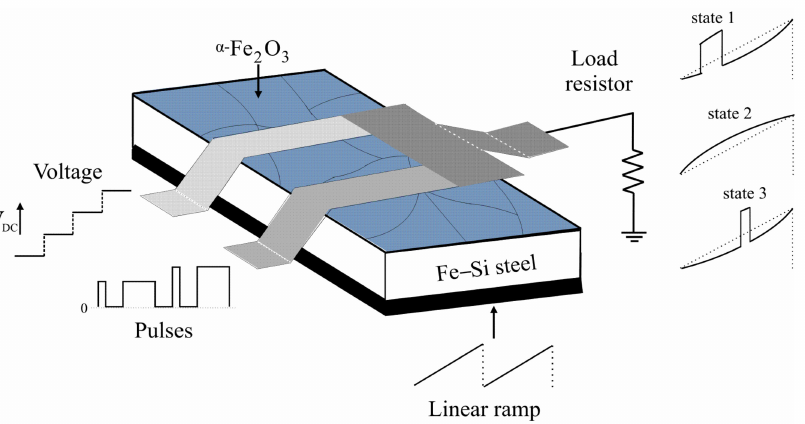
Figure 8. Theoretic arithmetic processor, inspired by electrical conduction properties of Fe–Si steel and graphite, mediated by α -Fe 2 O 3 oxide, to evaluate arithmetic values from weight states of the output